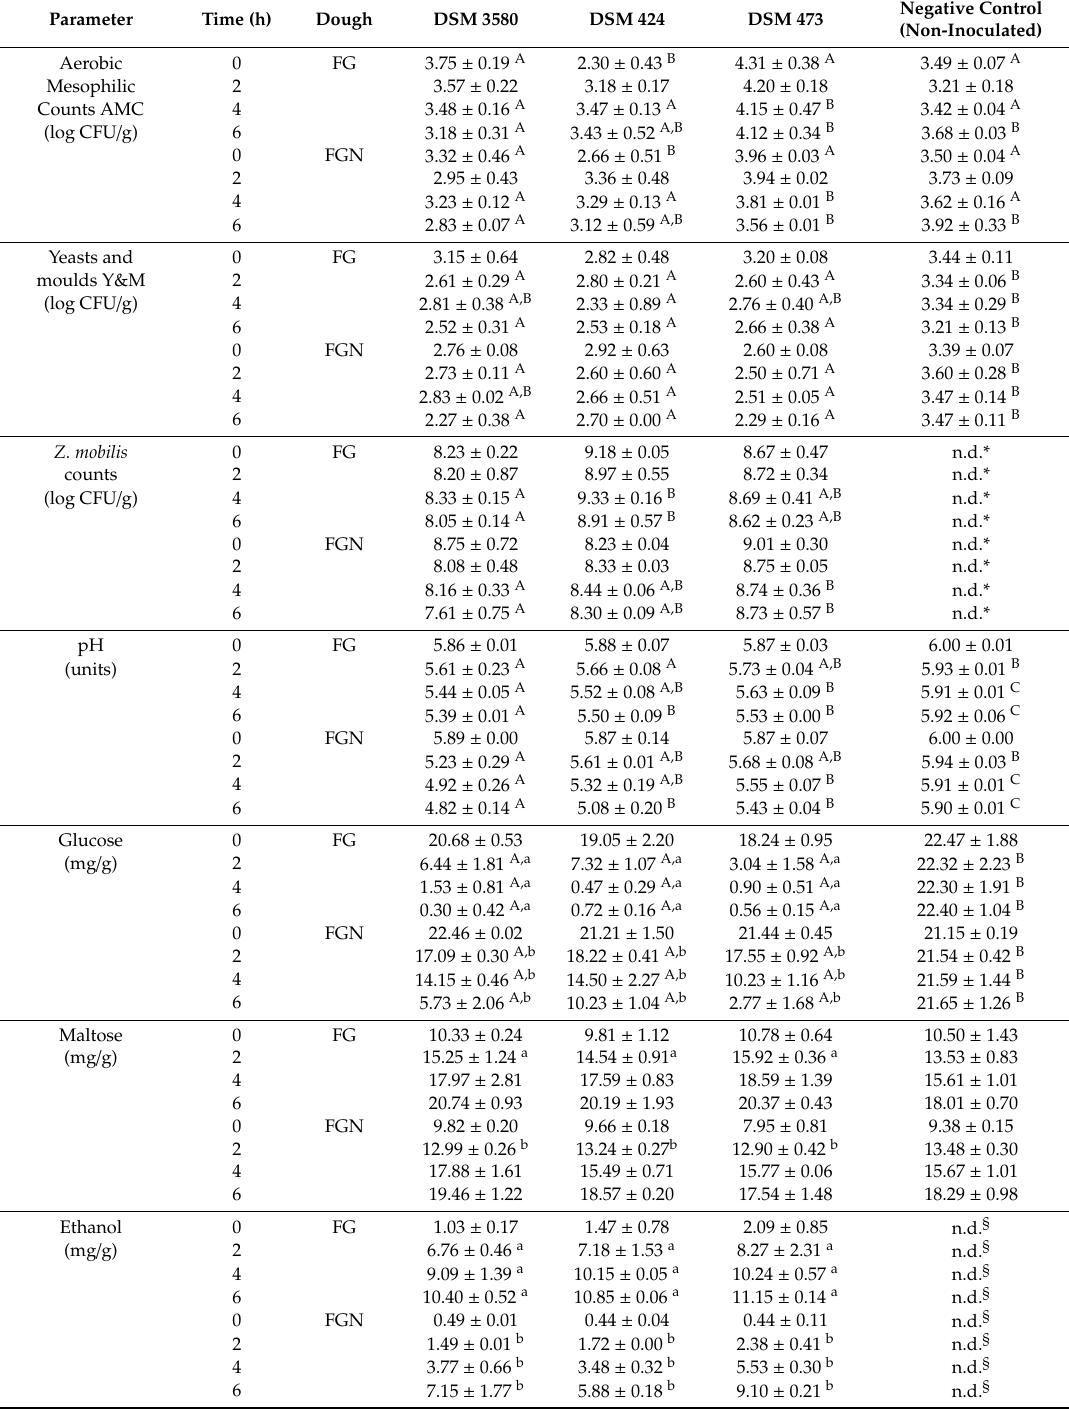
Table 2. Mean and standard deviation of microbial and chemical parameters detected in dough samples inoculated or not (negative control) with di ff erent Z. mobilis strains (DSM 3580, 424 and 473), collected during t0, 2, 4 and 6 h